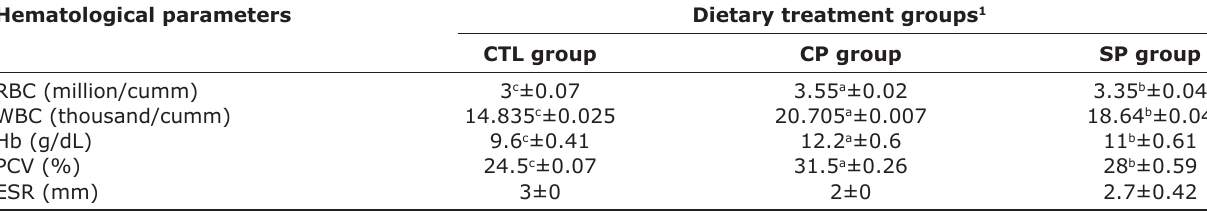
Table-3: Effects of dietary probiotic treatments on hematological parameters of broiler chickens. Hematological parameters